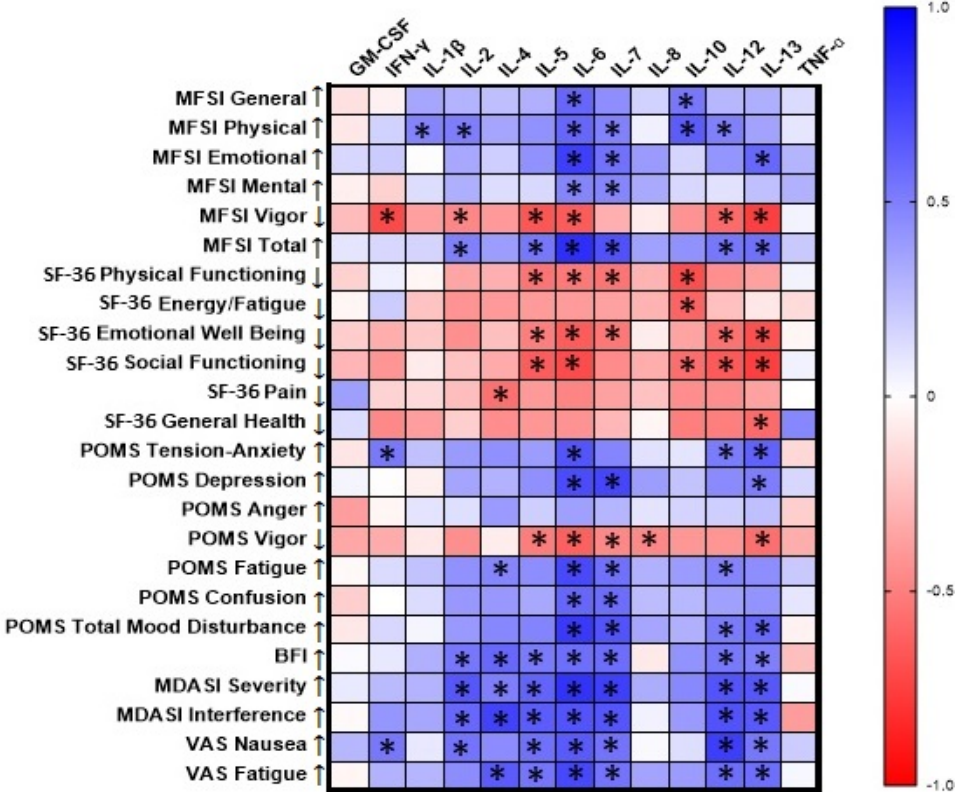
Figure 2. Correlations among baseline questionnaire scores and serum cytokine levels in cancer patients. Statistically significant correlations are denoted with an asterisk. Downward arrows indicate that lower scores are undesirable and indicate greater symptom severity; upward arrows indicate that higher scores are undesirable and indicate greater symptom severity. MFSI—Multidimensional Fatigue Symptom Inventory—Short Form, SF-36—RAND 36-Item Health Survey 1.0, POMS—Profile of Mood States—Short Form, BFI—Brief Fatigue Inventory, MDASI—MD Anderson Symptom Inventory, VAS—Visual Analog